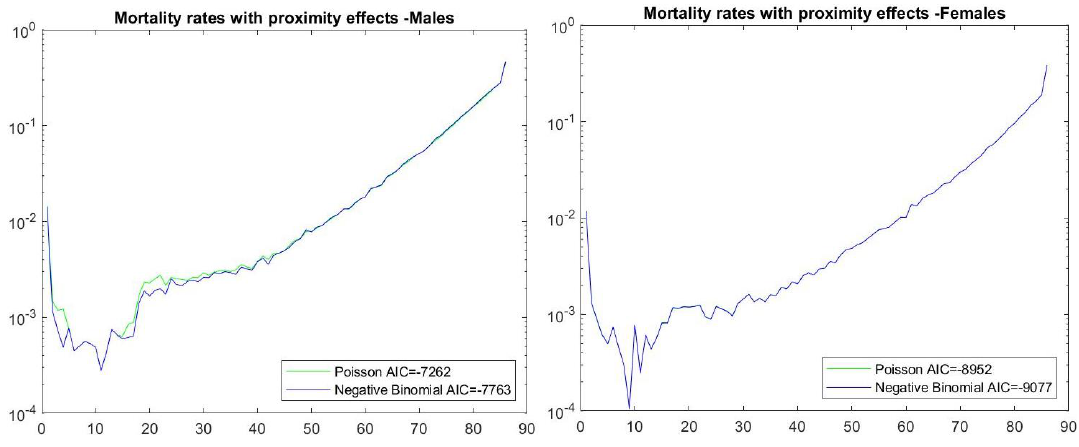
Figure 6. Comparative mortality rates.